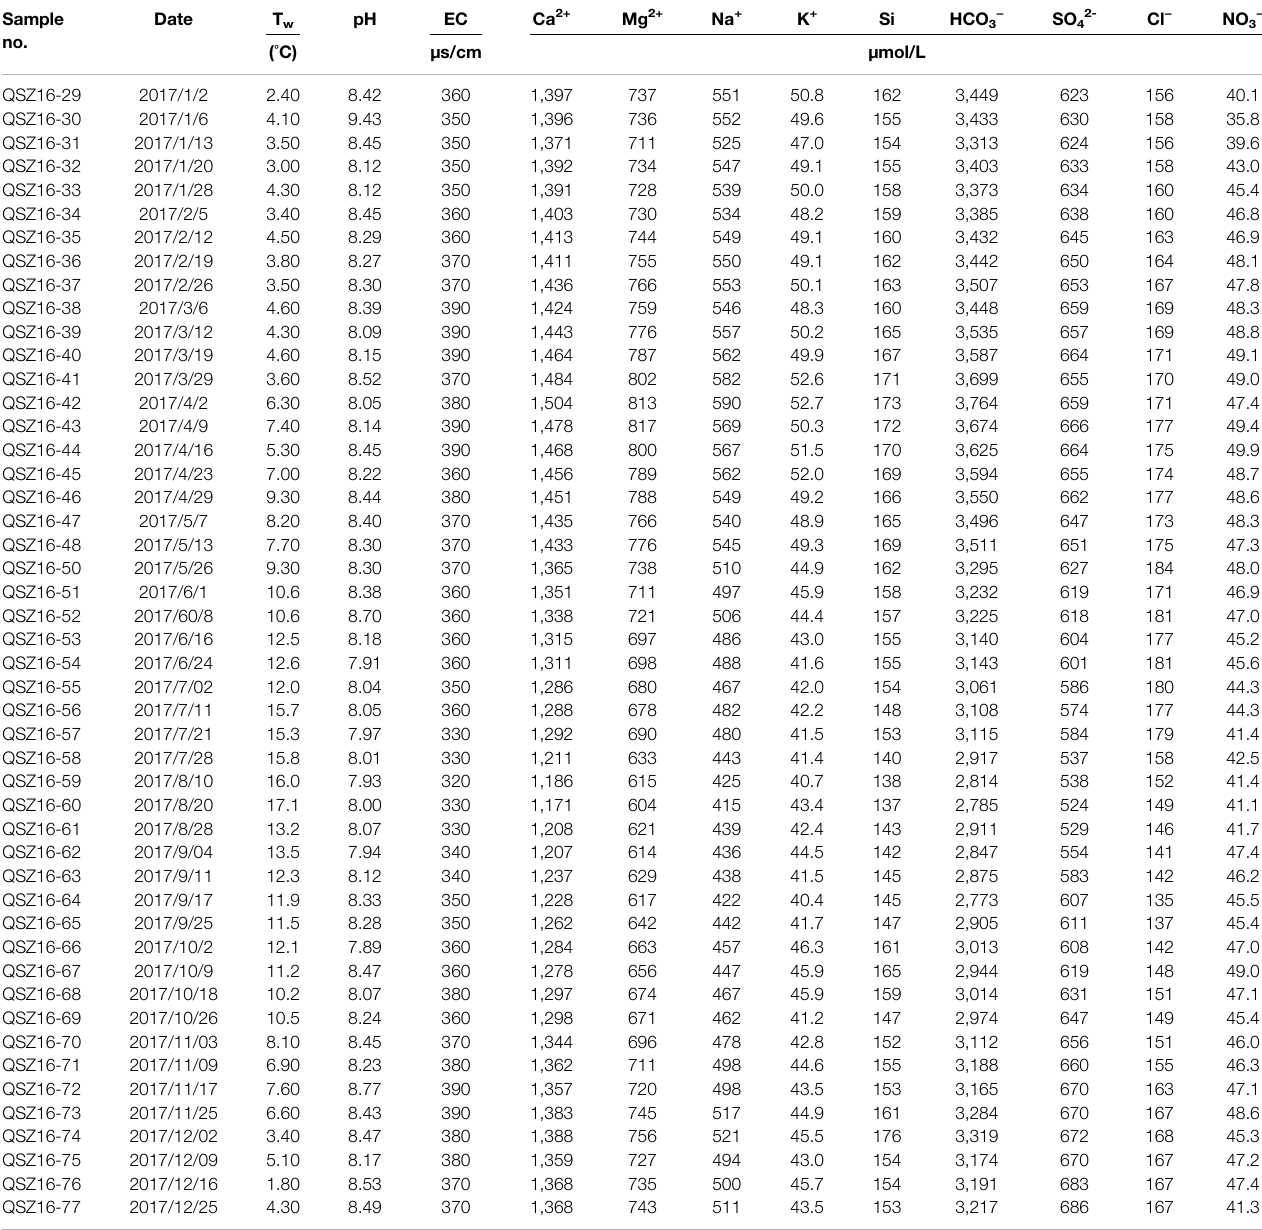
TABLE 1 | Physico-chemical parameters and major ion concentrations of river water in the Datong River. Sample